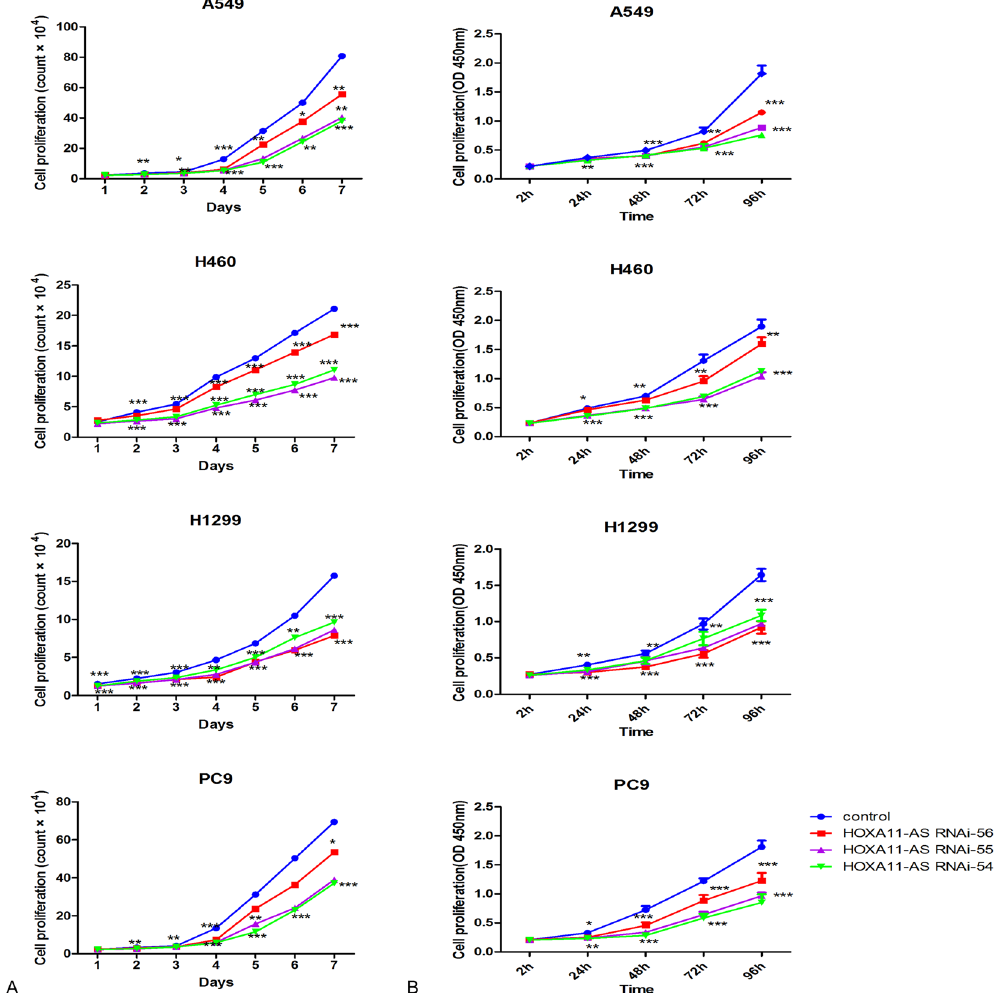
Figure 4. HOXA11-AS RNAi inhibited the proliferation of A549, H460, H1299 and PC9 cell lines ( * P < 0.05, ** P < 0.01, *** P < 0.001).(Note: control, lenti-control virus) The proliferation of A549, H460, H1299 and PC9 cell lines was inhibited based on a cytometry assay ( A ) and CCK-8 assay ( B